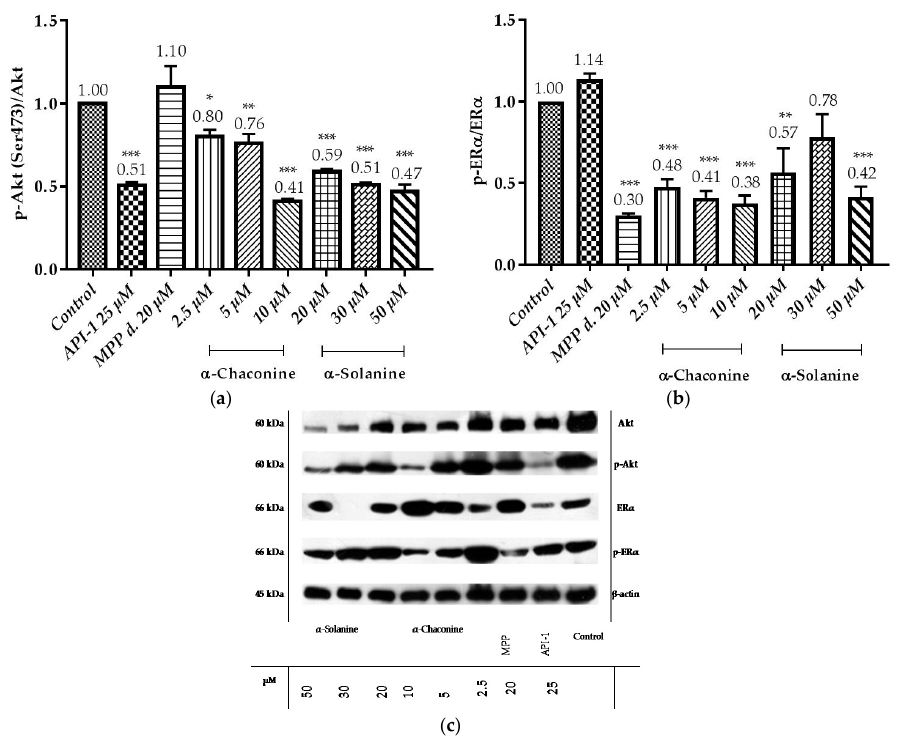
Figure 12. Western blot analysis of the expression of p-Akt, Akt, p-ER α and ER α proteins in the RL95-2 cell line: ( a ) In the bar graph the data represent the relative density of the bands p-Akt (Ser473)/Akt; ( b ) In the bar graph the data represent the relative density of the bands p-ER α /ER α ; ( c ) RL95-2 cells were treated with the compounds. The relative intensity is presented as mean ± SD. three independent experiments. * p < 0.1, ** p < 0.01 and *** p < 0.001 compared with the untreated control.